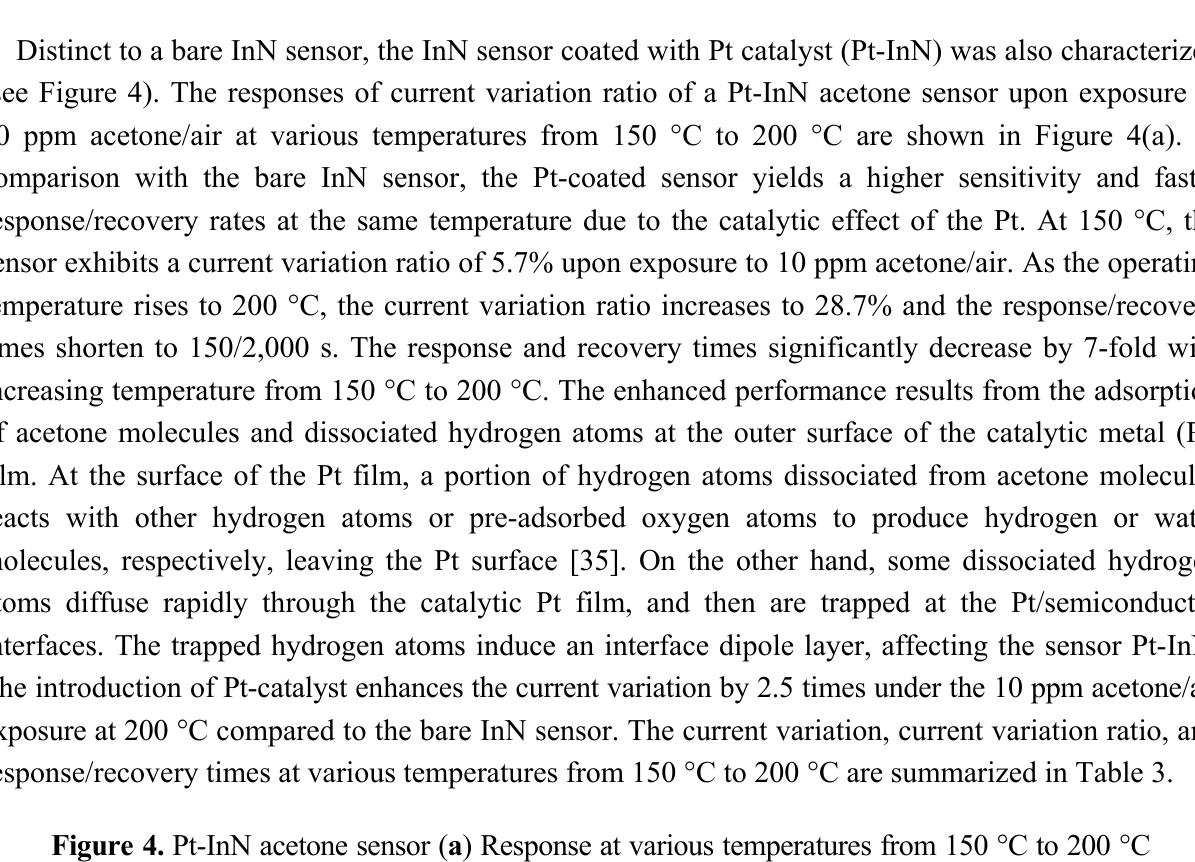
Figure 4. Pt-InN acetone sensor ( a ) Response at various temperatures from 150 ° C to 200 ° C in 10 ppm Acetone/air mixture ambiance; ( b ) Response of various acetone concentration (0.4 ppm–20 ppm), operating temperature at 200 ° C.